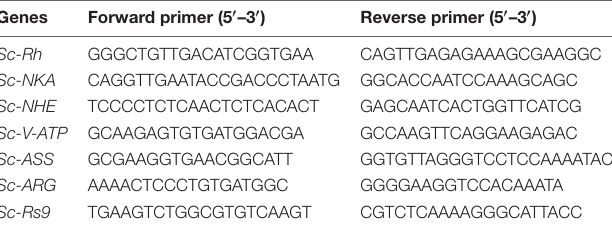
TABLE 1 | Primers used for qRT-PCR validation of differentially expressed genes. Genes Forward primer (5 (cid:48) –3 (cid:48) ) Reverse primer (5 (cid:48) –3 (cid:48) )